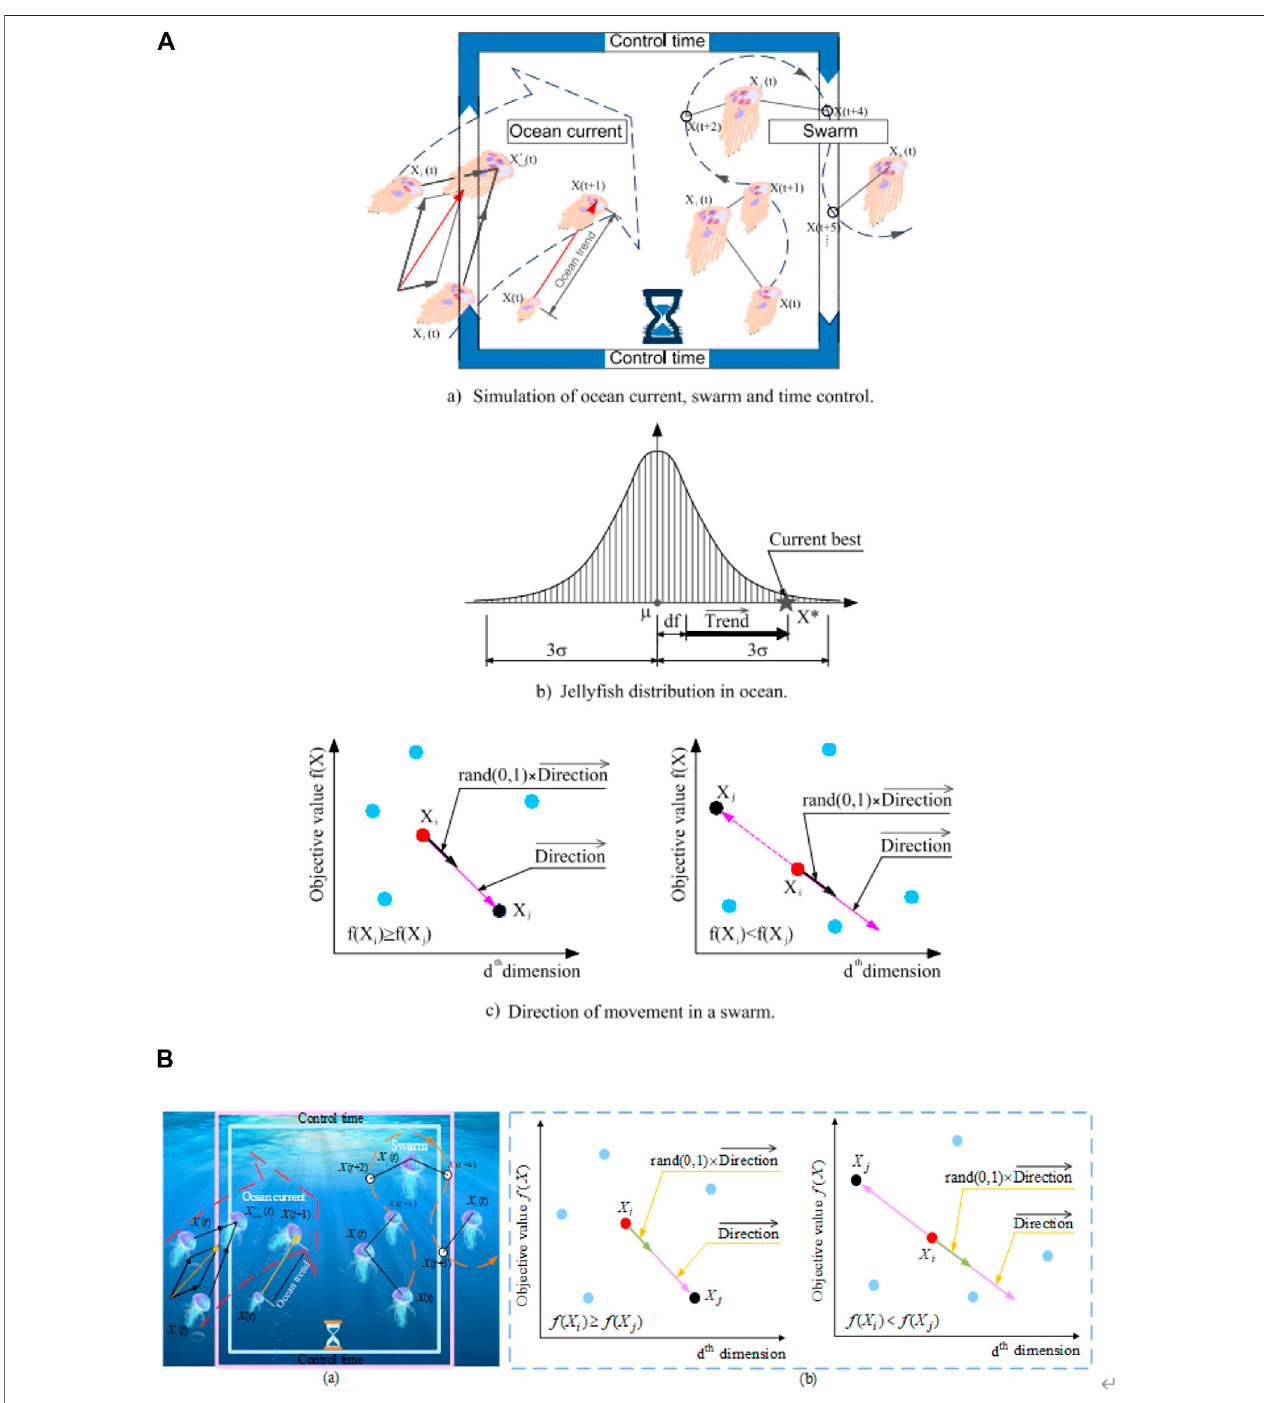
FIGURE 4 | Simulation of Jelly fi sh behavior. (A) the original fi gure source and (B) redecorated fi gure with citation.